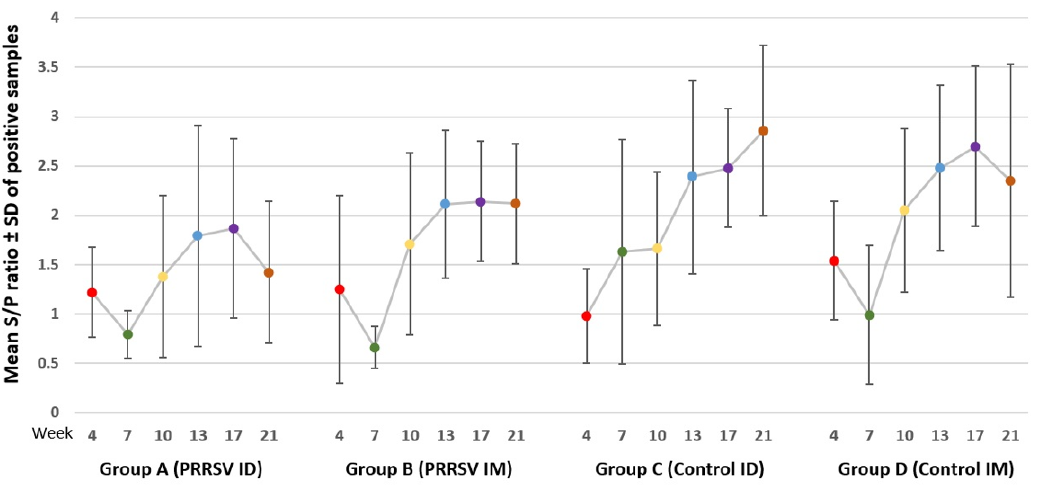
Figure 1. The results of ELISA examination (Mean S/P ratio ± SD) antibody-positive serum samples.